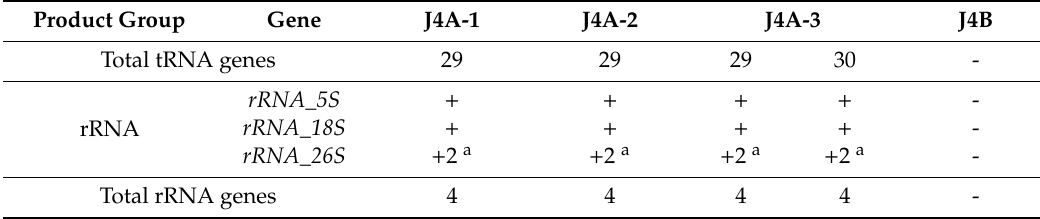
Table 3. Lengths and percentages of repeats ( ≥ 100 bp).